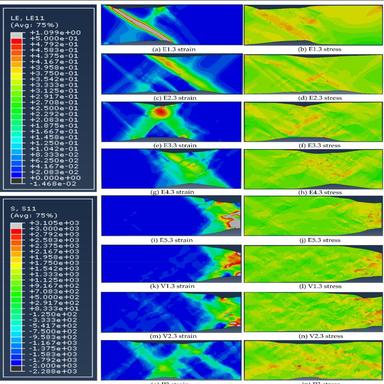
X (TD) strain and stress contours of different models.